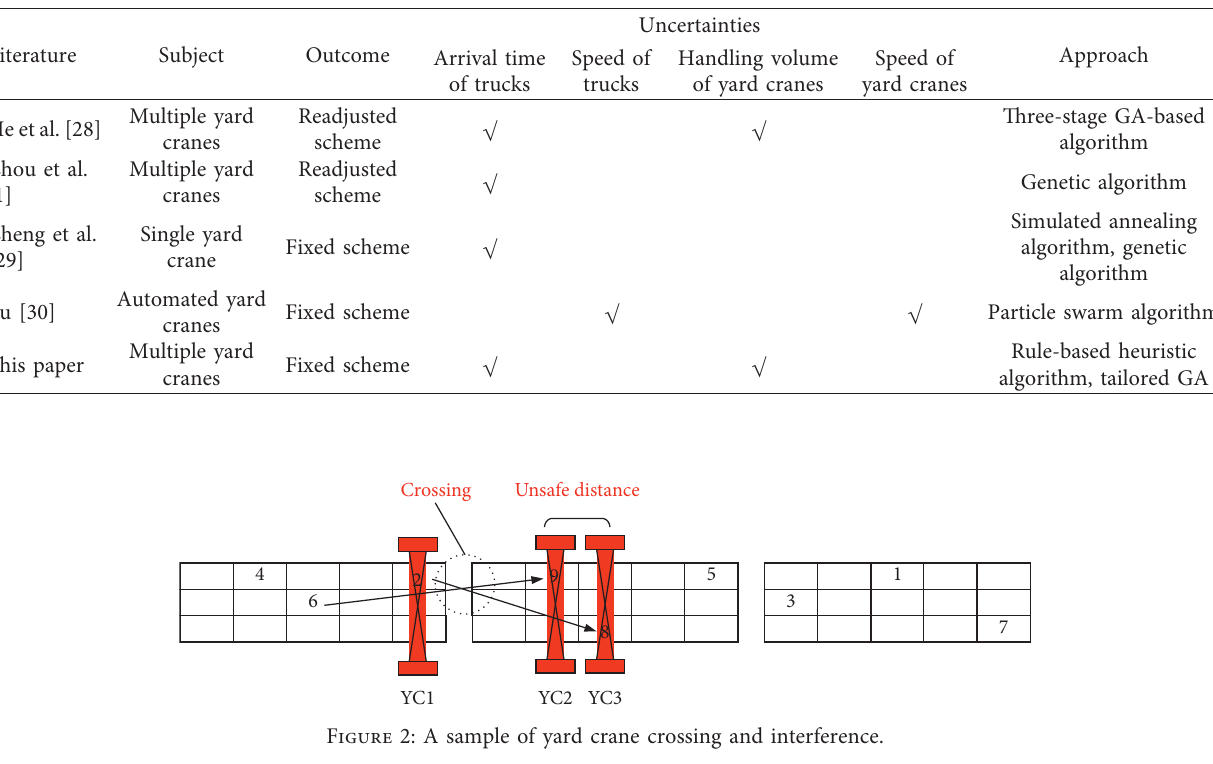
Table 1: Comparison of research on similar yard crane scheduling problem.